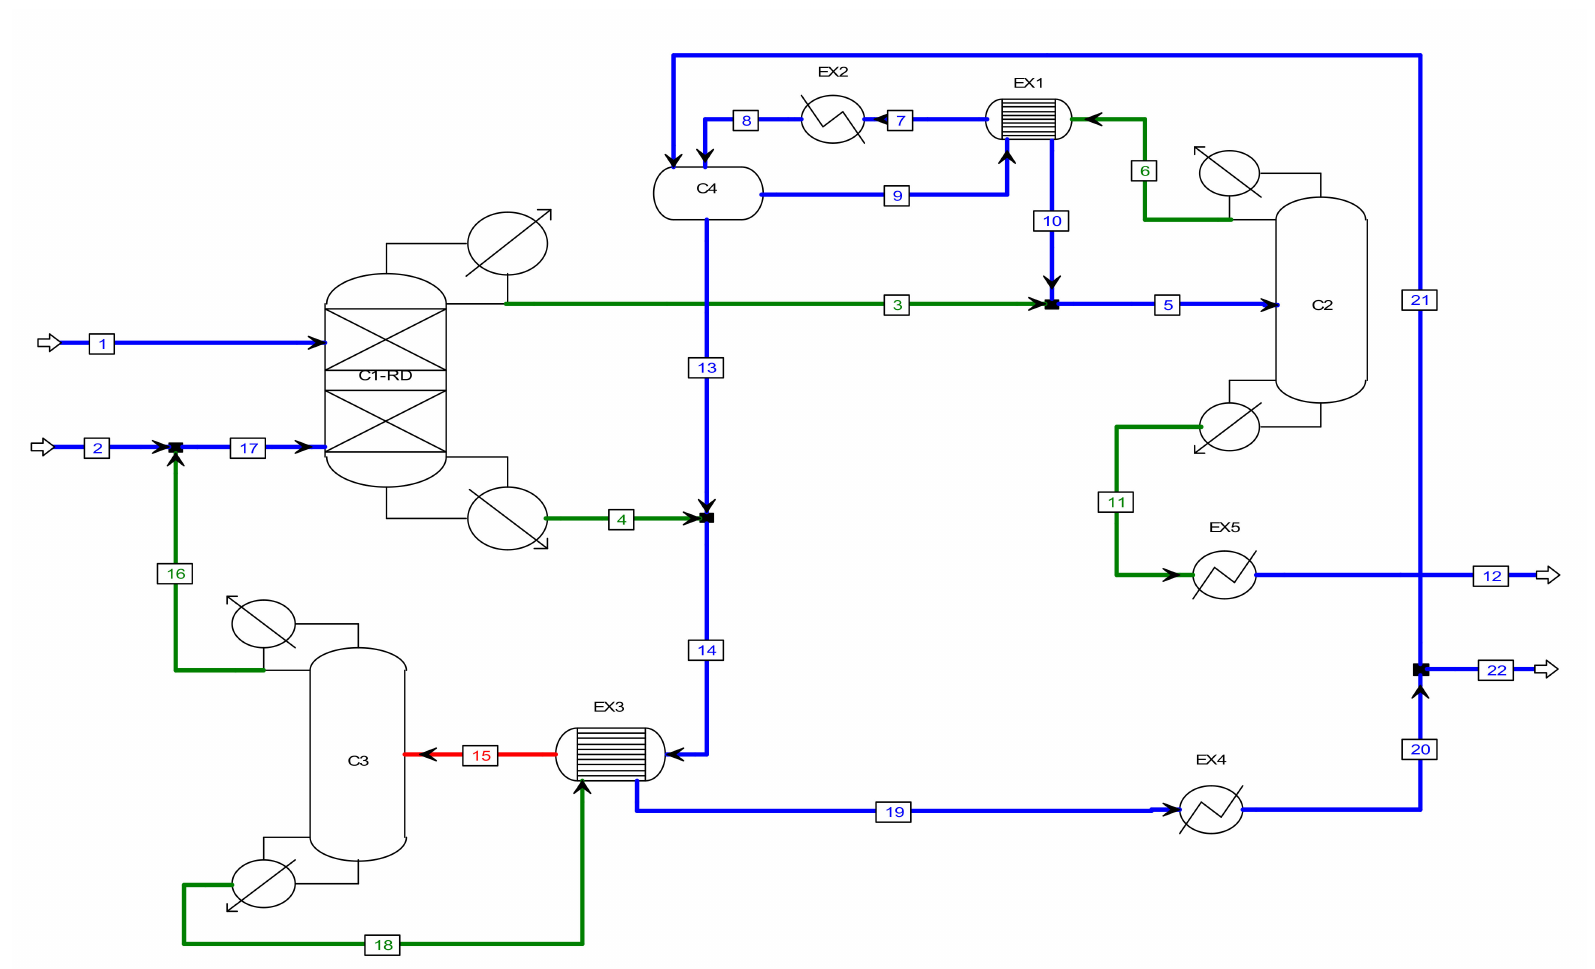
Figure 3. Ethyl acetate production via reactive distillation column with a separation unit adapted from our previous work [5]. Stream condition: blue—subcooled liquid; green—liquid at boiling temperature; red—vapor-liquid mixture. C1-RD—reactive distillation column; C2, C3—distillation columns; C4—decanter; EX1-5—heat